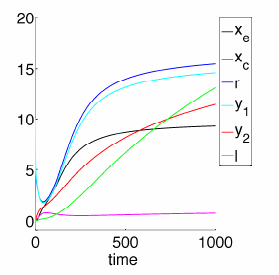
Fig. 11: Simulation of the basic model (Eq.(1)- (6)) with parameters from Table IV, α l = 0 . 001 and initial conditions x e = 10 and x c = r = y 1 = y = l = 0 2